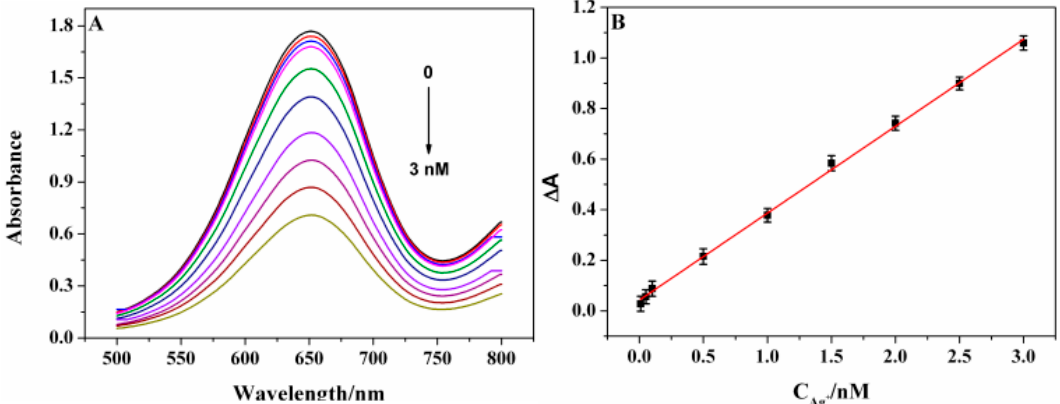
Figure 9. ( A ) Absorbance curves of the sensor for Ag + at various concentrations; and ( B ) the corresponding calibration plot of absorbance values against the Ag + concentrations (the error bars represent the standard deviation of three measurements).